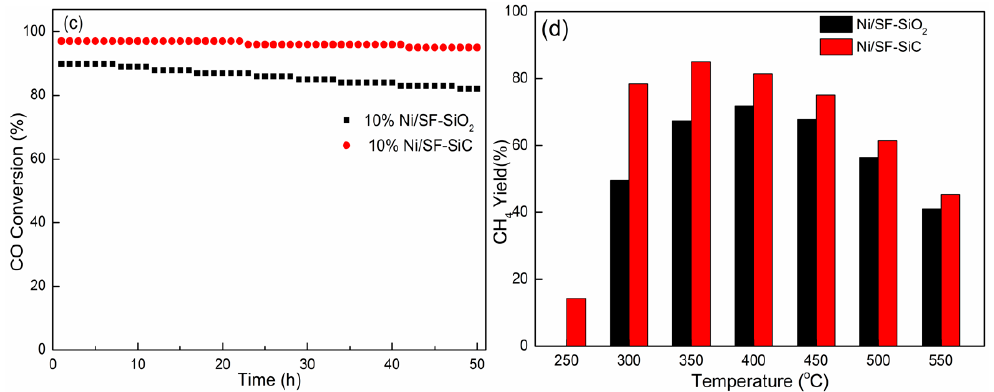
Figure 1. Catalytic performances of catalysts in CO methanation under different reaction temperatures at 0.1 MPa and GHSV of 18,000 mL · g − 1 · h − 1 : ( a ) CO Conversion, ( b ) CH 4 Selectivity and ( d ) CH 4 yield of Ni/SF-SiO 2 and Ni/SF-SiC; ( c ) long-time stability test of Ni/SF-SiO 2 and Ni/SF-SiC at 350 ◦ C, 0.1 MPa and GHSV of 18000 mL · g − 1 · h − 1 .